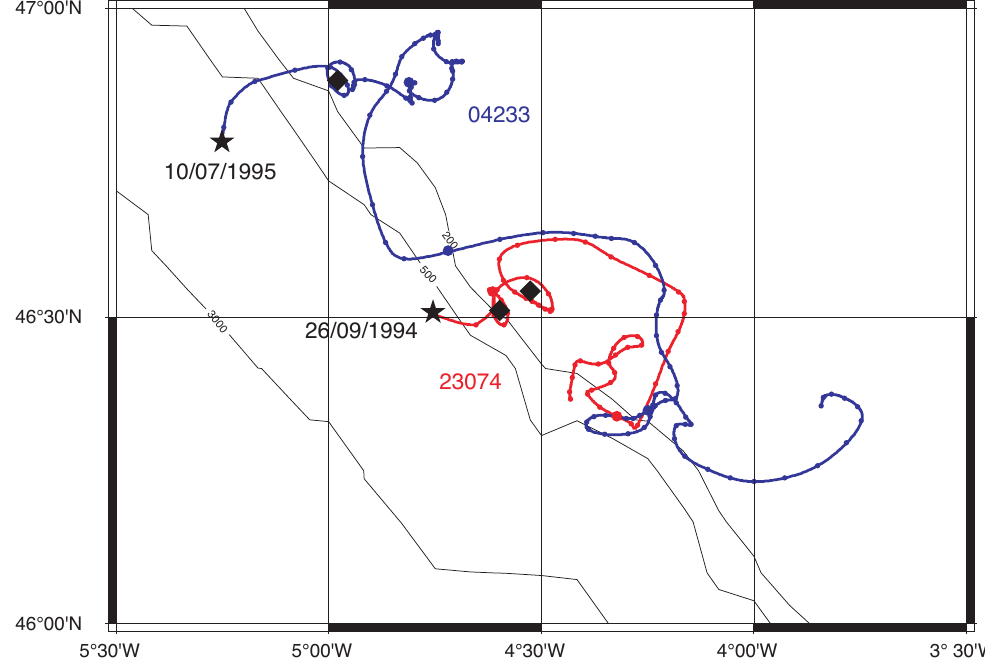
F IG . 6. – Low-pass filtered trajectories of surdrifts 04233 (deployed on September 1994, blue) and 23074 (deployed on July 1995, red), drogued at 80 m. Deployment positions and dates are indicated on the figure (black stars). Small coloured dots indicate days and unlabeled bigger coloured dots indicate beginning of months. Diamonds ( ♦ ) indicate the positions of the Outer Shelf AntiCyclones (OSAC